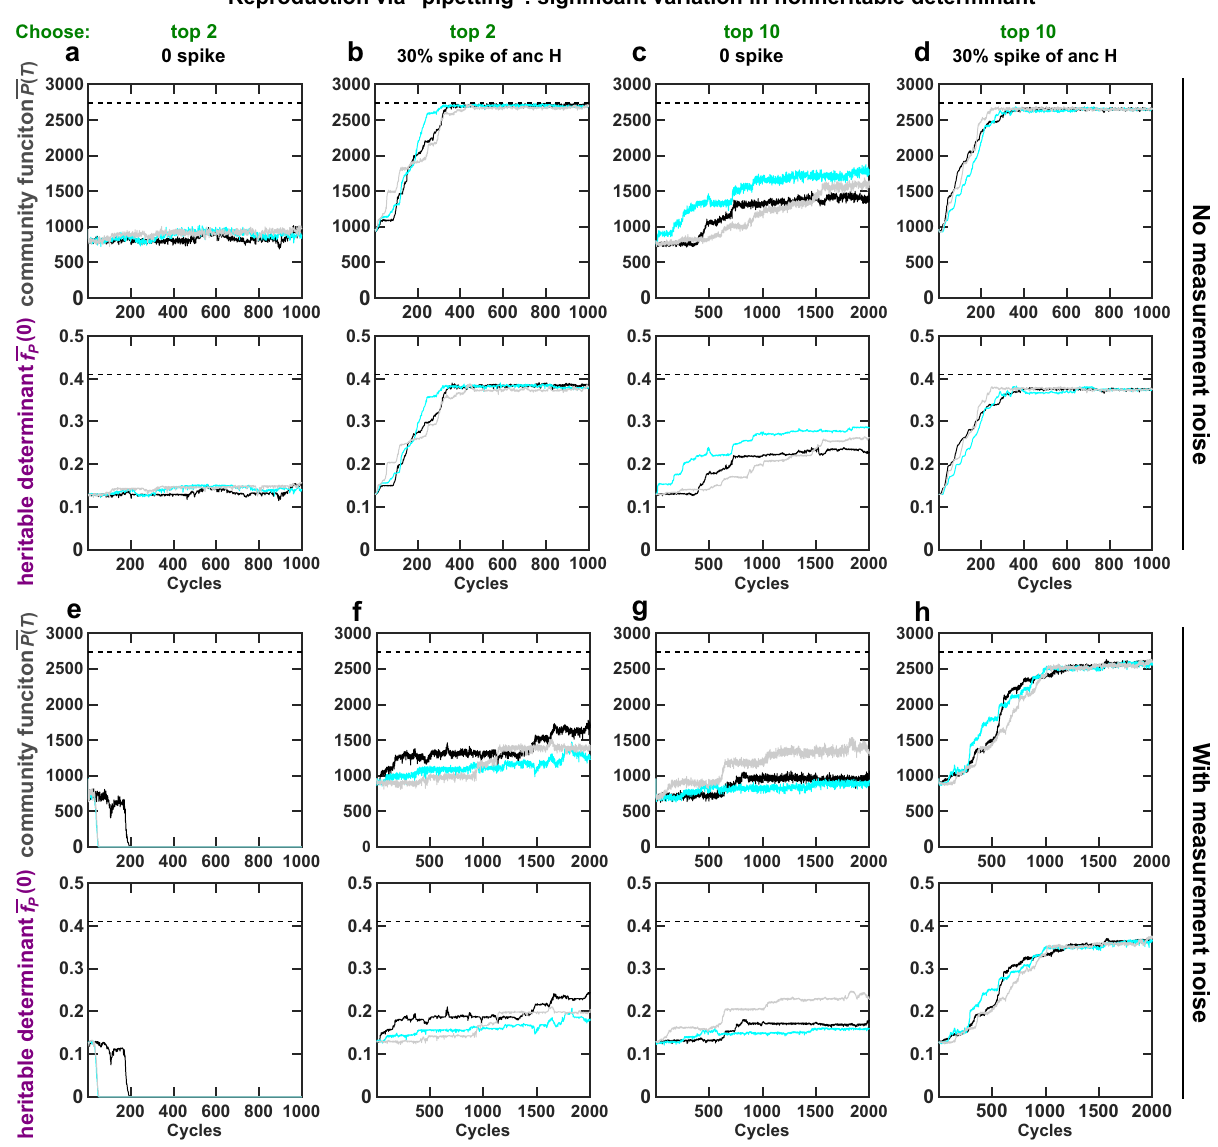
Fig. 6 Increasing community function heritability by shifting Newborn restrictor can improve selection ef fi cacy under various conditions. Evolutionary dynamics of community function P ( T ) and its heritable determinant f P ð 0 Þ averaged over the chosen communities under different selection schemes are plotted. Species composition is allowed to stochastically fl uctuate during community reproduction, as if pipetting an inoculum of a fi xed total biomass from an Adult to seed its Newborns. In all cases, community selection is more effective under the 30%-H spiking strategy ( b , d , f , and h , where 30% of Newborn biomass is replaced by the nonevolving H) compared with the no-spiking strategy ( a , c , e and g ). In “ top-2 ” strategy ( a , b , e and f ), top-2 communities each reproduces 50 Newborns. In “ top-10 ” strategy ( c , d , g and h ), top 10 communities each reproduces 10 Newborns. In “ no measurement noise ” ( a – d ), the measured community function is the true community function obtained in the simulation. In “ with measurement noise ” ( e – h ), measured community function is the sum of the true community function and a normal random variable with a mean of 0 and a standard deviation of 100. Dashed lines correspond to theoretical maximal community function or M ’ s cost f (cid:2) optimal for community function. Black, cyan, and gray curves represent three P independent